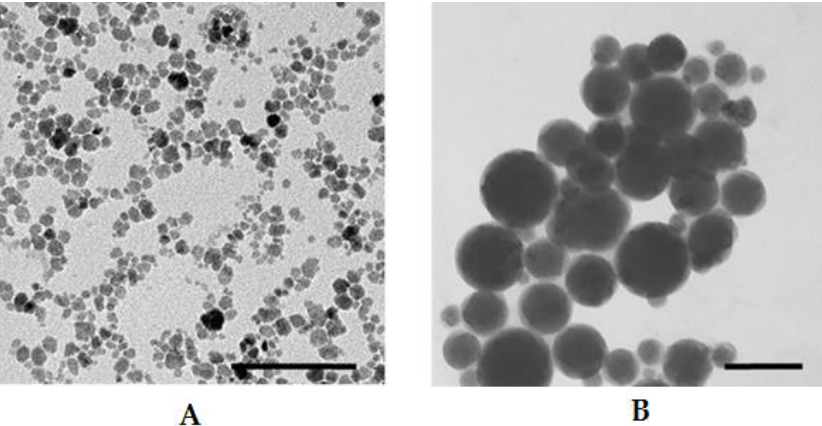
Figure 6 . TEM images of ( A ) γ -Fe 2 O 3 nanoparticles and ( B ) magnetoliposomes (MLs) formed by magnetic nanoparticles (MNPs) coated with citrate ions ( γ -Fe 2 O 3 – citr 55 mg/mL) and 1,4-DHP 1 ; n DHP /n γ -Fe2O3 = 0.04. Scale bar is 100 nm. MLs obtained by the reverse-phase evaporation (REV) method.